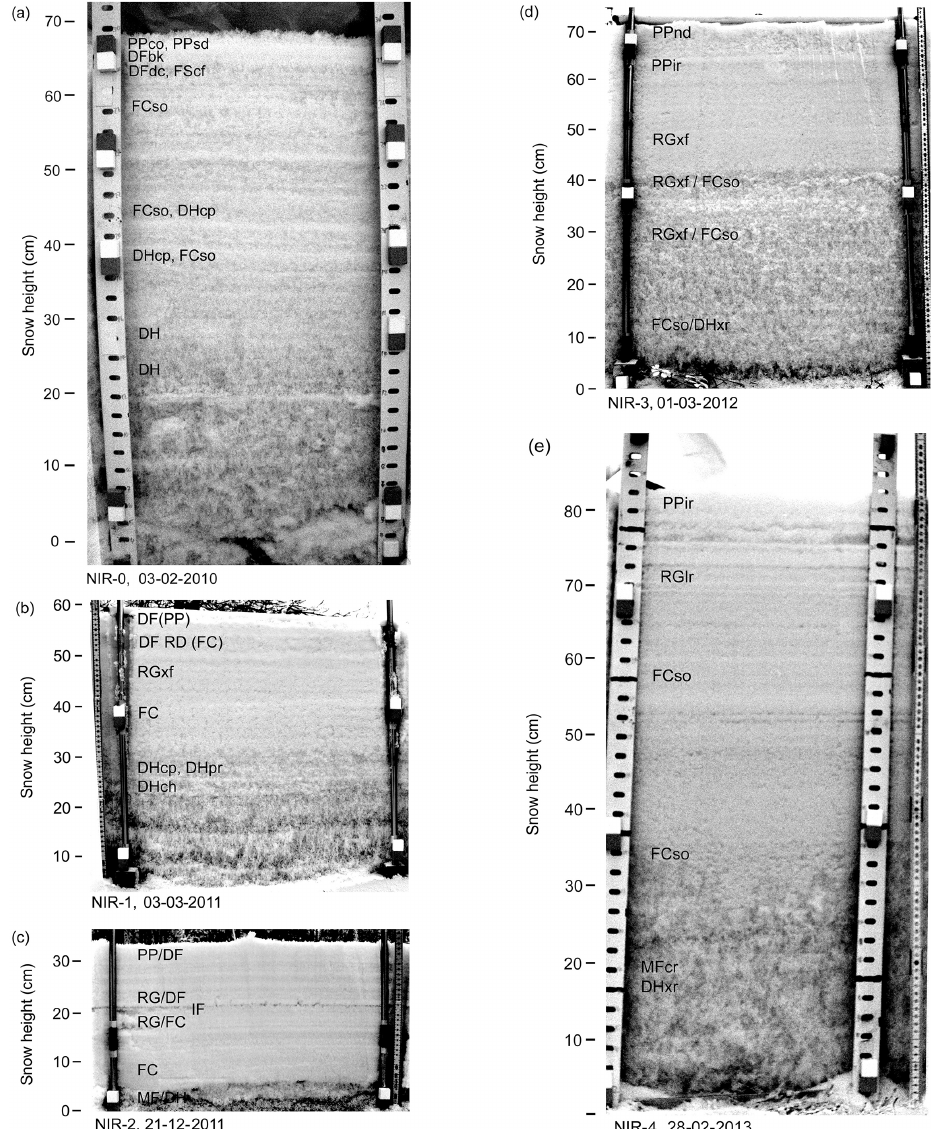
Figure 9. NIR photography of the snowpack. The image NIR-0 was acquired in the first season on 23 February 2010 where no CT data are available. The other images NIR-1, NIR-2, NIR-3, and NIR-4 correspond to the CT profiles CT-1, CT-2, CT-3, and CT-4. The intensity of the NIR photography is mainly determined by grain size but also shows the metamorphic state of the snowpack. The NIR photography provides an independent measure for the absolute depth of individual snow layers and helps to identify strong structural transition in the snowpack.